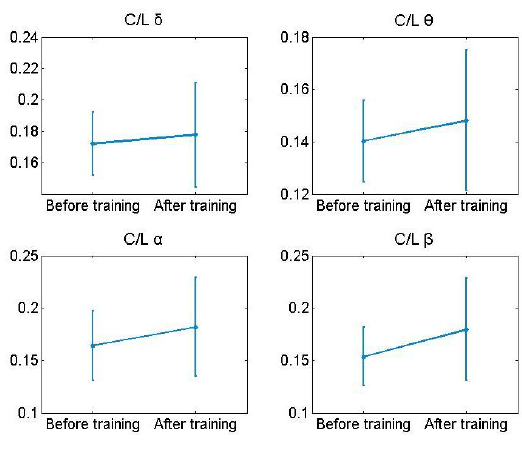
Figure 5. The ratios C/L of different frequency bands change after training.